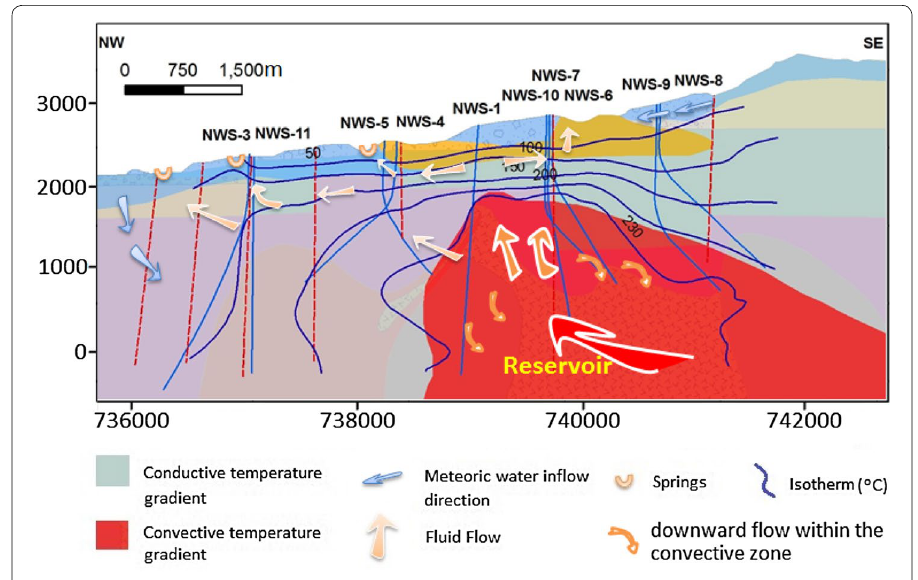
Fig. 11 Overall conceptual model of NW Sabalan geothermal